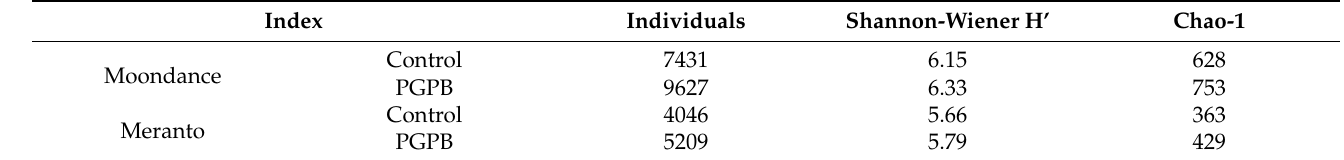
Table 3. Ecological indexes calculated from Illumina sequencing